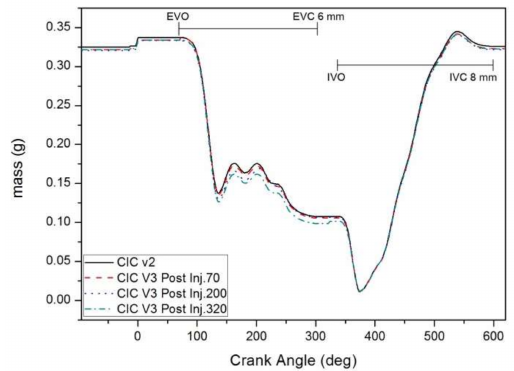
Figure 11. Total trapped mass traces for different recompression strategies with three post injections.